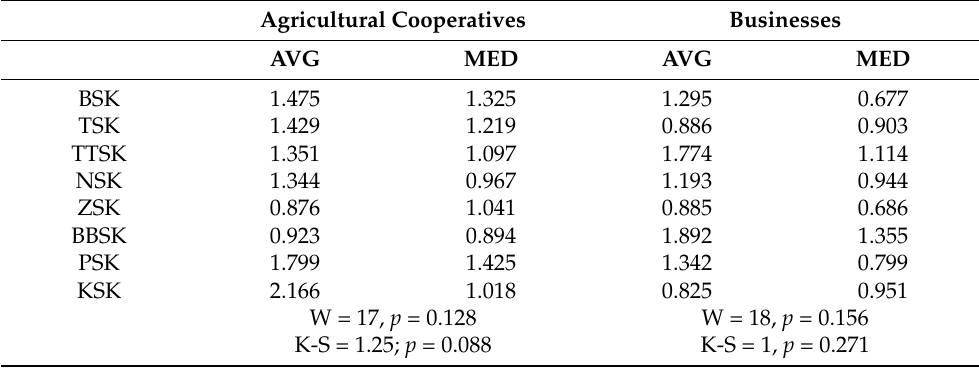
Table 5. Overall assessment of regions using two mean values (average, median).